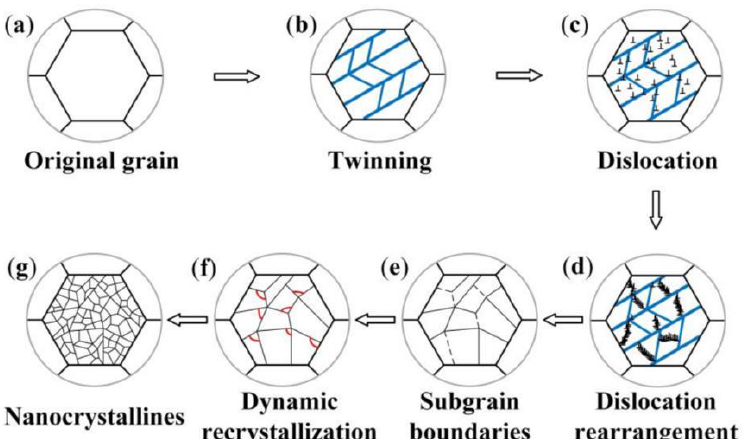
Figure 8. Schematic presentation of grain refinement mechanism in AZ91D subjected to USRP: ( a ) original grain, ( b ) twinning, ( c ) dislocation, ( d ) dislocation rearrangement, ( e ) subgrain boundaries, ( f ) DRX, and ( g ) nanocrystallines. Reprinted with permission from ref. [68]. Copyright 2020 MDPI.